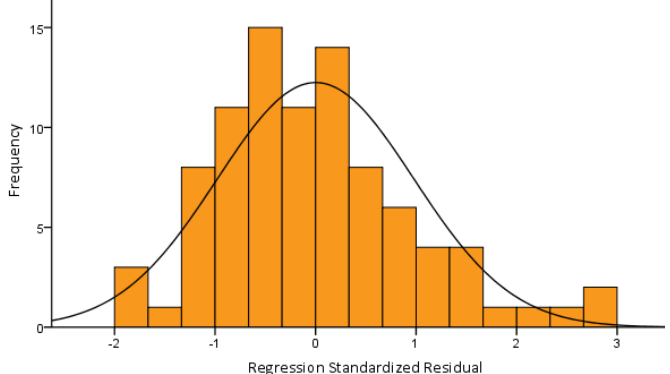
Fig. 3: Residual histogram plots for normality assumption